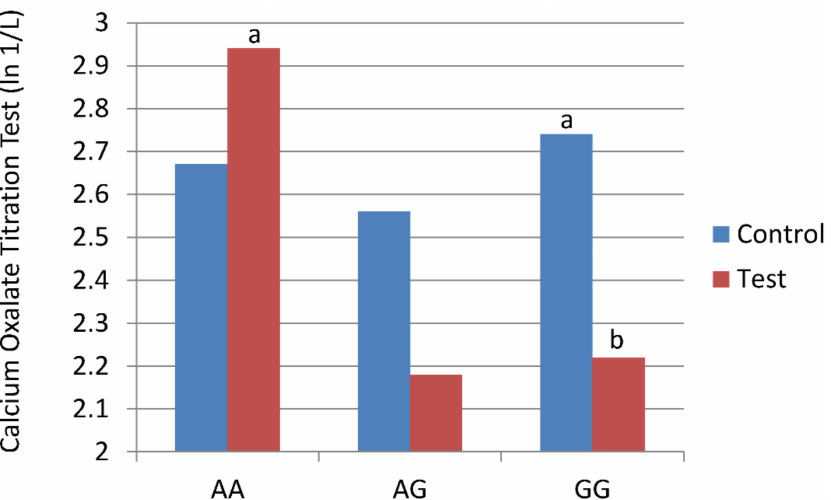
Figure 2. Cats with three alanine-glyoxylate aminotransferase 2 (AGXT2) single nucleotide polymor- phisms (SNPs: GG, AG, and AA) were fed control food or test food for 28 days in a cross-over study design. Stone risk analysis for calcium oxalate crystal formation, assessed using the calcium oxalate titrimetric (COT) test, showed that cats with the GG variant of the AGXT2 SNP had lower values (decreased susceptibility to added oxalate before forming calcium oxalate crystals) after consuming test food compared with control food. a,b Means with different superscripts are different ( p < 0.05; largest Std Error = e 0.40 ).